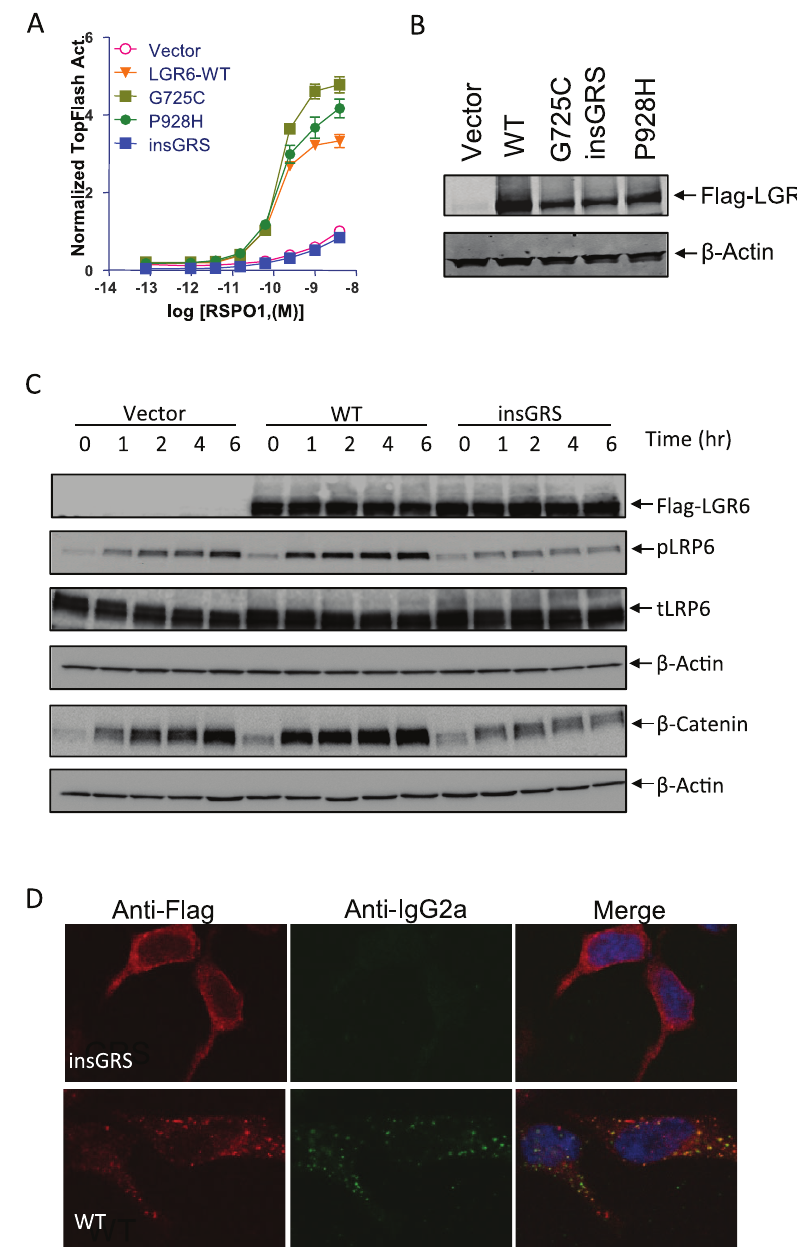
Figure 4. Functional and binding analyses of LGR6 mutants. A, TOPFlash assay of LGR6 mutants on RSPO1-induced potentiation of Wnt/ b - catenin signaling. HEK293T cells were transiently transfected with expression plasmids as indicated with a combination of super 8 6 TOPFlash and pRL-SV40 reporter gene constructs, and then stimulated with serial dilutions of purified recombinant RSPO1 in the presence of Wnt3a CM. All error bars are SEM (n=4). B, Expression levels of LGR6 mutants and WT in HEK 293T cells in transient transfection paradigms. Total cell lysates were treated with Laemmli buffer for 1 hr at 37 u C, fractionated by SDS-PAGE using 4–20% gels, electrophoretically transferred to nitrocellulose membrane, and then probed with anti-Flag antibody. The signal was detected by ECL Western blotting detection reagents (Amersham Biosciences). b -actin was also probed as loading control. C, Time course of changes in Wnt3a-RSPO1-induced b -catenin accumulation and LRP6 phosphorylation in vector, LGR6-WT and insGRS-overexpressing cells. HEK293 cells stably expressing vector, LGR6-WT or insGRS were stimulated with 1 ng/ml RSPO1 plus Wnt3a CM for 0–6 hrs. Total cell lysates were probed with antibodies against Flag-LGR6, phosphor-Ser1490, total LRP6, and b -actin. For the analysis of nonmembrane-bound b -catenin, the cell lysates were cleared with ConA-sepharose beads and then probed with an antibody against b -catenin as described before [9]. D, mRSPO1-Fc binding to LGR6-insGRS and WT. HEK293 cells stably expressing Flag-LGR6-WT or insGRS were incubated with mRSPO1-Fc at 37 u C for 1 hr. The cells were fixed, permeabilized, and then co-stained with anti-Flag (red) and anti-IgG2a (green) antibodies to detect LGR6 and mRSPO1-Fc, respectively. Nuclei (blue) were counterstained with To-Pro-3. doi:10.1371/journal.pone.0037137.g004 identified, all of which are distinct missense mutations with the of three mutations in random, total exon sequencing of 37 colon exception of one truncation [21], supporting its role as a tumor cancer samples [17]. A transcriptome-wide approach showed that suppressor. For LGR6, the initial evidence came from the finding LGR6 is hypermethylated in the promoter region in , 20% of